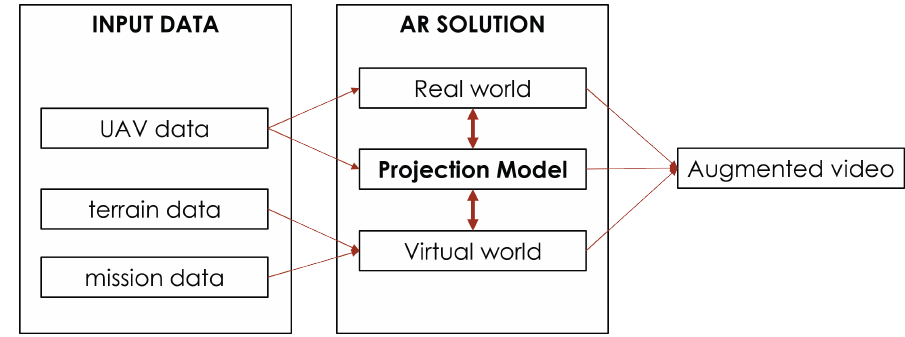
Figure 2. Principal modules of the AR tool: input data processing, AR solution and augmented